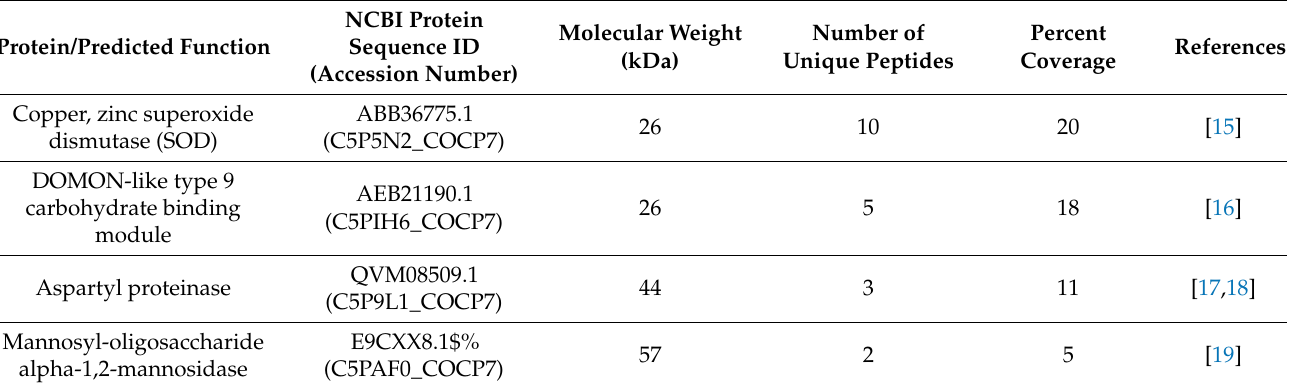
Table 1. Immunoreactive proteins on the surface of C. posadasii S/E spherules. Surface proteins were isolated by Trypsin shaving of intact spherules, separated by SDS-PAGE electrophoresis and excised polypeptide band was identified by mass